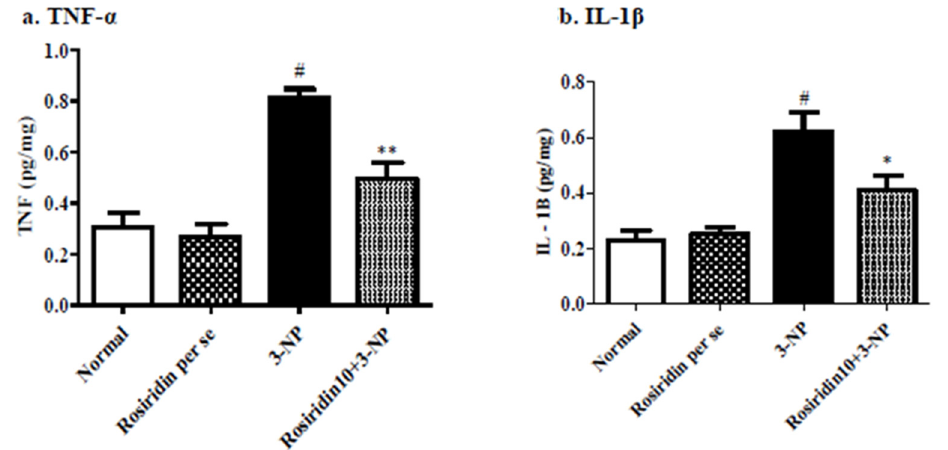
Figure 6. Effect of rosiridin on proinflammatory biomarkers (( a ) TNF- α and ( b ) IL-1 β ). Values are expressed as the mean ± SEM (n = 6). Values are statistically significant at p < 0.05 (one-way ANOVA followed by Dunnett’s test). Express the data ( # p < 0.05) saline vs. negative control group; (** p < 0.01; * p < 0.05) negative control group vs. treatment group.